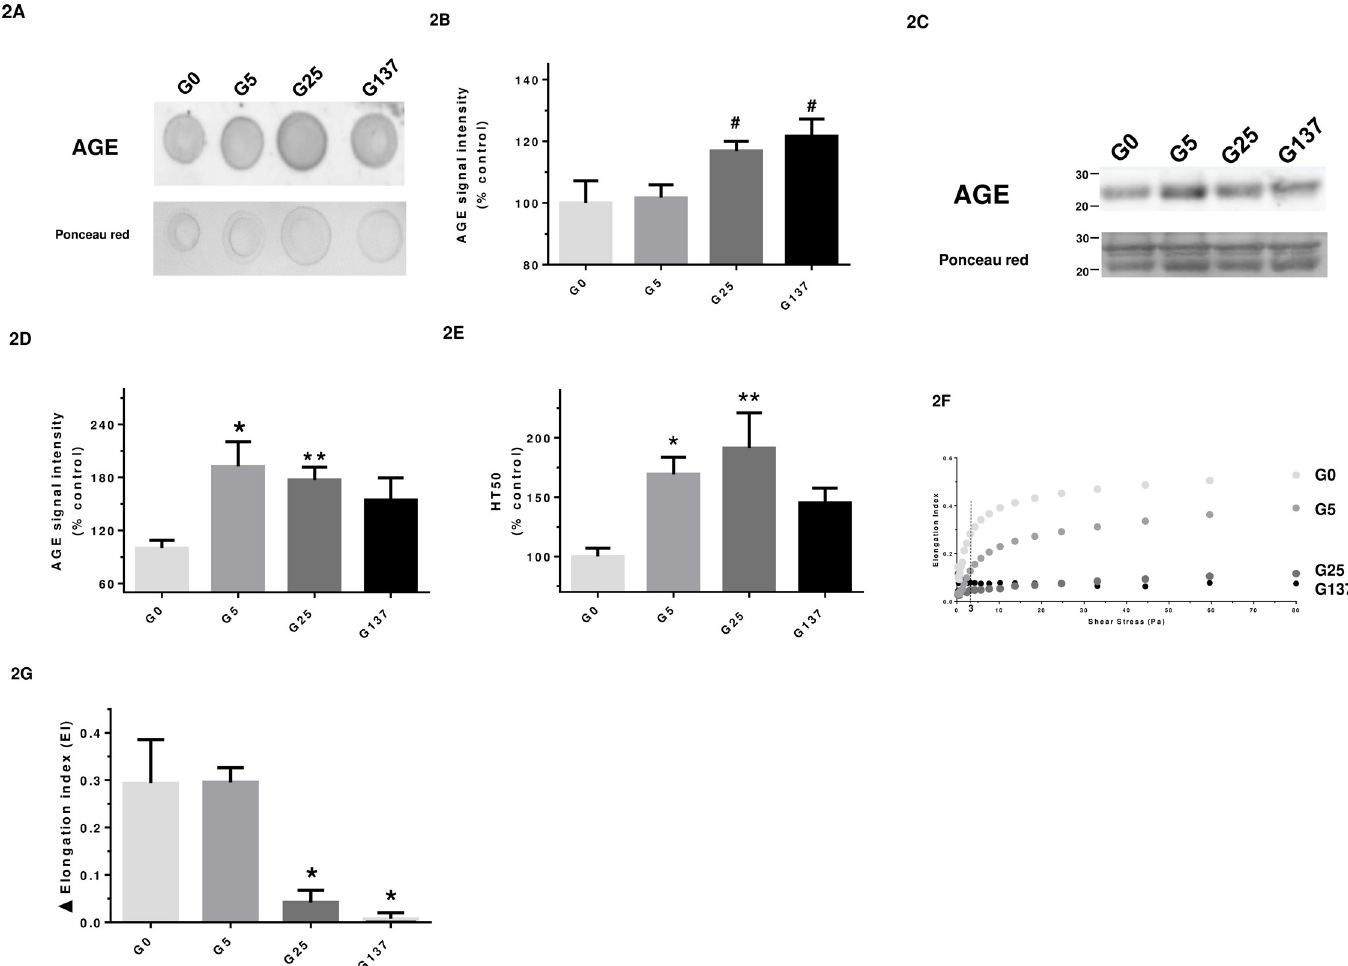
Fig 2. Glycated erythrocytes exhibit an impaired deformability capacity. In this figure, G0, G5, G25 and G137 represent the four conditions of incubation to which erythrocytes were subjected: 0, 5, 25 and 137 mmol/l glucose, respectively. (A) Representative AGE dot blot performed on lysate preparations (n = 4); (B) Quantification of AGE signal normalized with Ponceau S signal in the different erythrocyte preparations. Results are expressed as mean ± SEM of 3 to 4 experiments performed independently. # p < 0.05 vs . G5 (Student’s t test, n = 3 to 4); (C) Representative AGE western blot performed on lysate preparations (n = 4); (D) Quantification of AGE signal normalized with ponceau red signal in the different erythrocyte preparations. Results are expressed as mean ± SEM of 4 experiments performed independently. � p < 0.05, �� p < 0.01 vs. G0 (Student’s t test, n = 4). (E) HT50 was measured by the free-radical hemolysis test as described in method section. Results are expressed as mean ± SEM of 5 to 8 experiments performed independently. � p < 0.05, �� p < 0.01 indicates a significant difference vs . G0 (One-way ANOVA followed by Dunnett’s test) n = 5 independent analyses; (F) Curves correspond to the elongation index of erythrocytes determined by LORRCA measurement as a function of shear stress intensity (Pa); (G) Histograms correspond to the calculated variation in elongation index (delta EI) reflecting capacity of erythrocytes to deform when submitted to a shear stress ranking from 0 to 80 Pa. Results are expressed as mean ± SEM. � p < 0.05 indicates a significant difference as compared to G0 (One-way ANOVA followed by Dunnett’s test) n = 3 independent